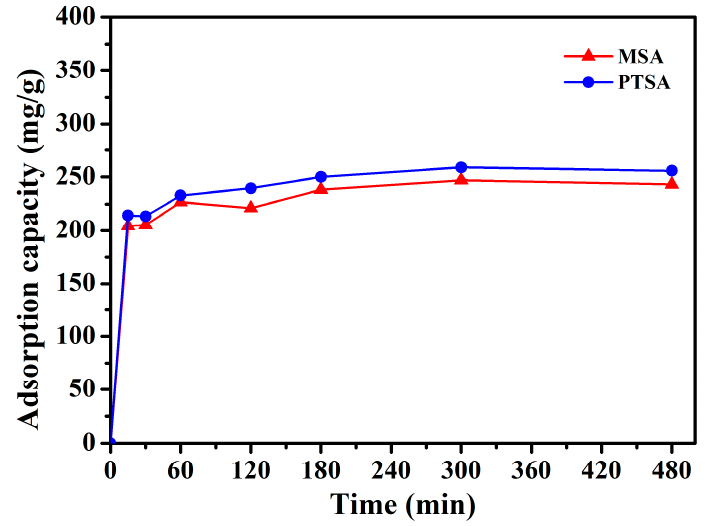
Figure 4. The effect of impregnation time on the content of acids in the